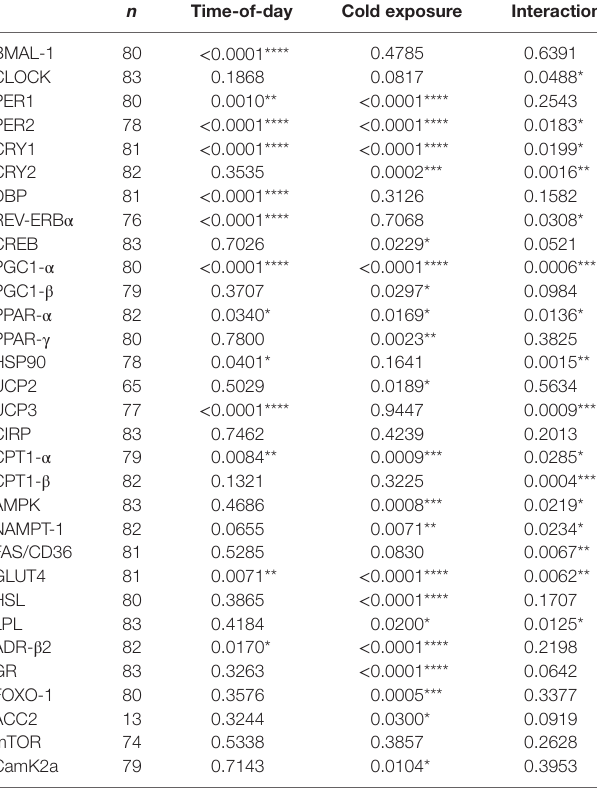
TaBle 5 | Significance levels observed for the two­way ANOVA analysis of the gene expression in the soleus muscle.